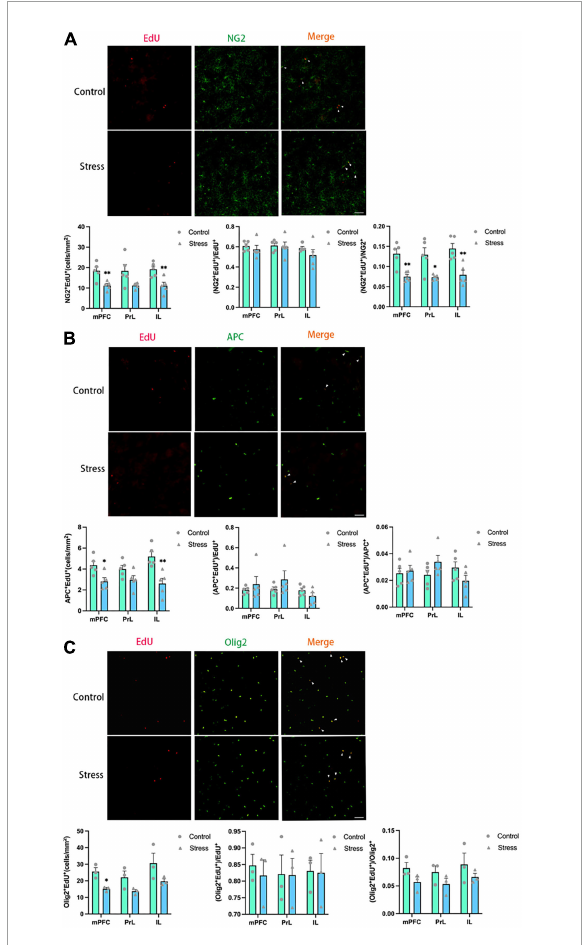
FIGURE4 Chronic social defeat stress (CSDS) reduces oligodendrogenesis in the medial prefrontal cortex (mPFC) of adolescent mice. (A) Representative images (upper panels) of newly generated cells (EdU + ; red), OPCs (NG2 + ; green), and newly formed OPCs (NG2 + EdU + ; orange) in the mPFC and the bar graphs (lower panels) showing the number of NG2 + EdU + , the percentage of NG2 + EdU + in the total EdU + cells, and the percentage of NG2 + EdU + in the total NG2 + cells in the total mPFC area and its subregions. The white arrowhead indicates the newly formed OPCs. (B) Representative images (upper panels) of newly generated cells (EdU + ; red), mature OLs (APC + ; green), and newly formed mature OLs (EdU + APC + ; orange) in the mPFC and the bar graphs (lower panels) showing the number of APC + EdU + , the percentage of APC + EdU + in the total EdU + cells, and the percentage of APC + EdU + in the total APC+ cells in the total mPFC area and its subregions. The white arrowhead indicates the newly formed mature OLs. (C) Representative images (upper panels) of newly generated cells (EdU + ; red), OLLs, (Olig2 + ; green), and newly formed OLLs (EdU + Olig2 + ; orange) in the mPFC and the bar graphs (lower panels) showing the number of Olig2 + EdU + , the percentage of Olig2 + EdU + in the total EdU + cells, and the percentage of Olig2 + EdU + in the total Olig2 + cells in the total mPFC area and its subregions. The white arrowhead indicates the newly formed OLLs. Magnification: 100 × . Scale bars: 50 µ m. Data are expressed as mean ± SEM. The number of animals used is as follow: NG2 + EdU + (control, n = 5; stress, n = 5); APC + EdU + (control, n = 5; stress, n = 5); Olig2 + EdU + (control, n = 3; stress, n = 3), ∗ P < 0.05, ∗∗ P < 0.01, Stress vs.